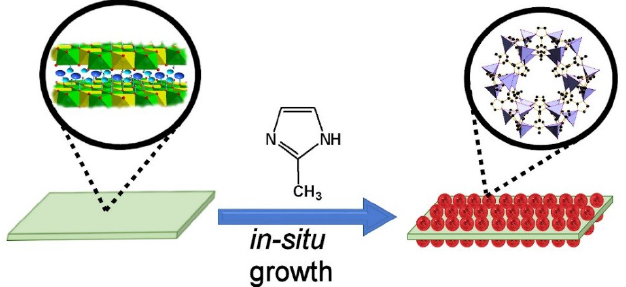
Figure 17. In situ growth of ZIF-8 nanocrystals on Zn–Al–LDH. (Colour scheme: Zn, purple; C, black; H 2 O, blue spheres; A n − , cyan spheres). Adapted from Dalton Trans. 2016 , 45 , 12632–12635. Copyright (2016) Royal Society of Chemistry.